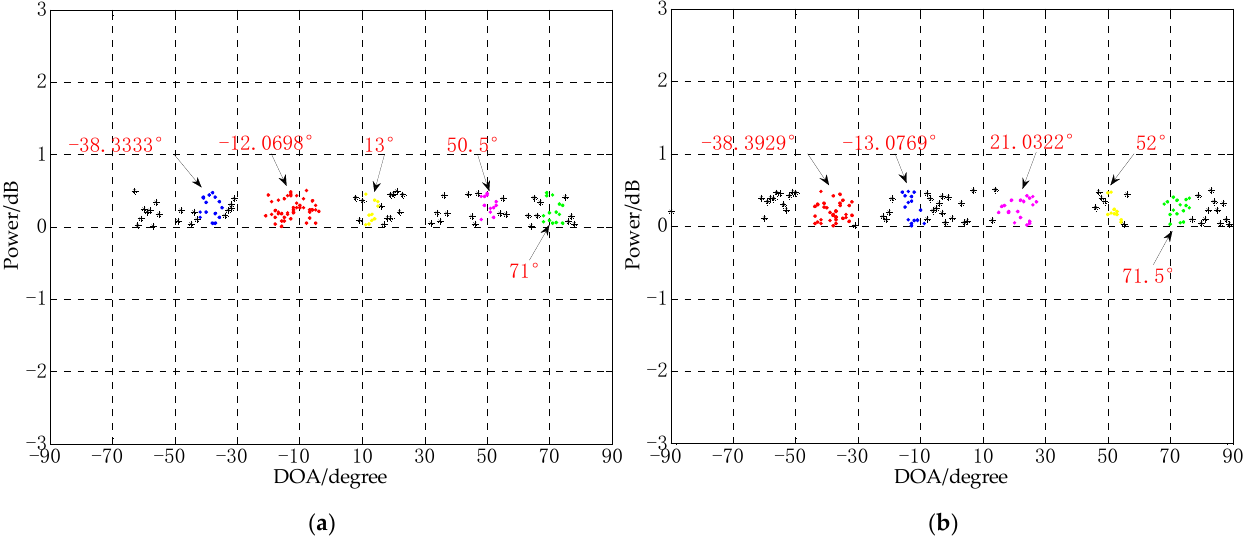
Figure 10. The DOA estimation experiment of the CS-DOA-DBSCAN algorithm in a multi-source environment, ( a ) the number of array elements is 6; ( b ) the number of array elements is 8.